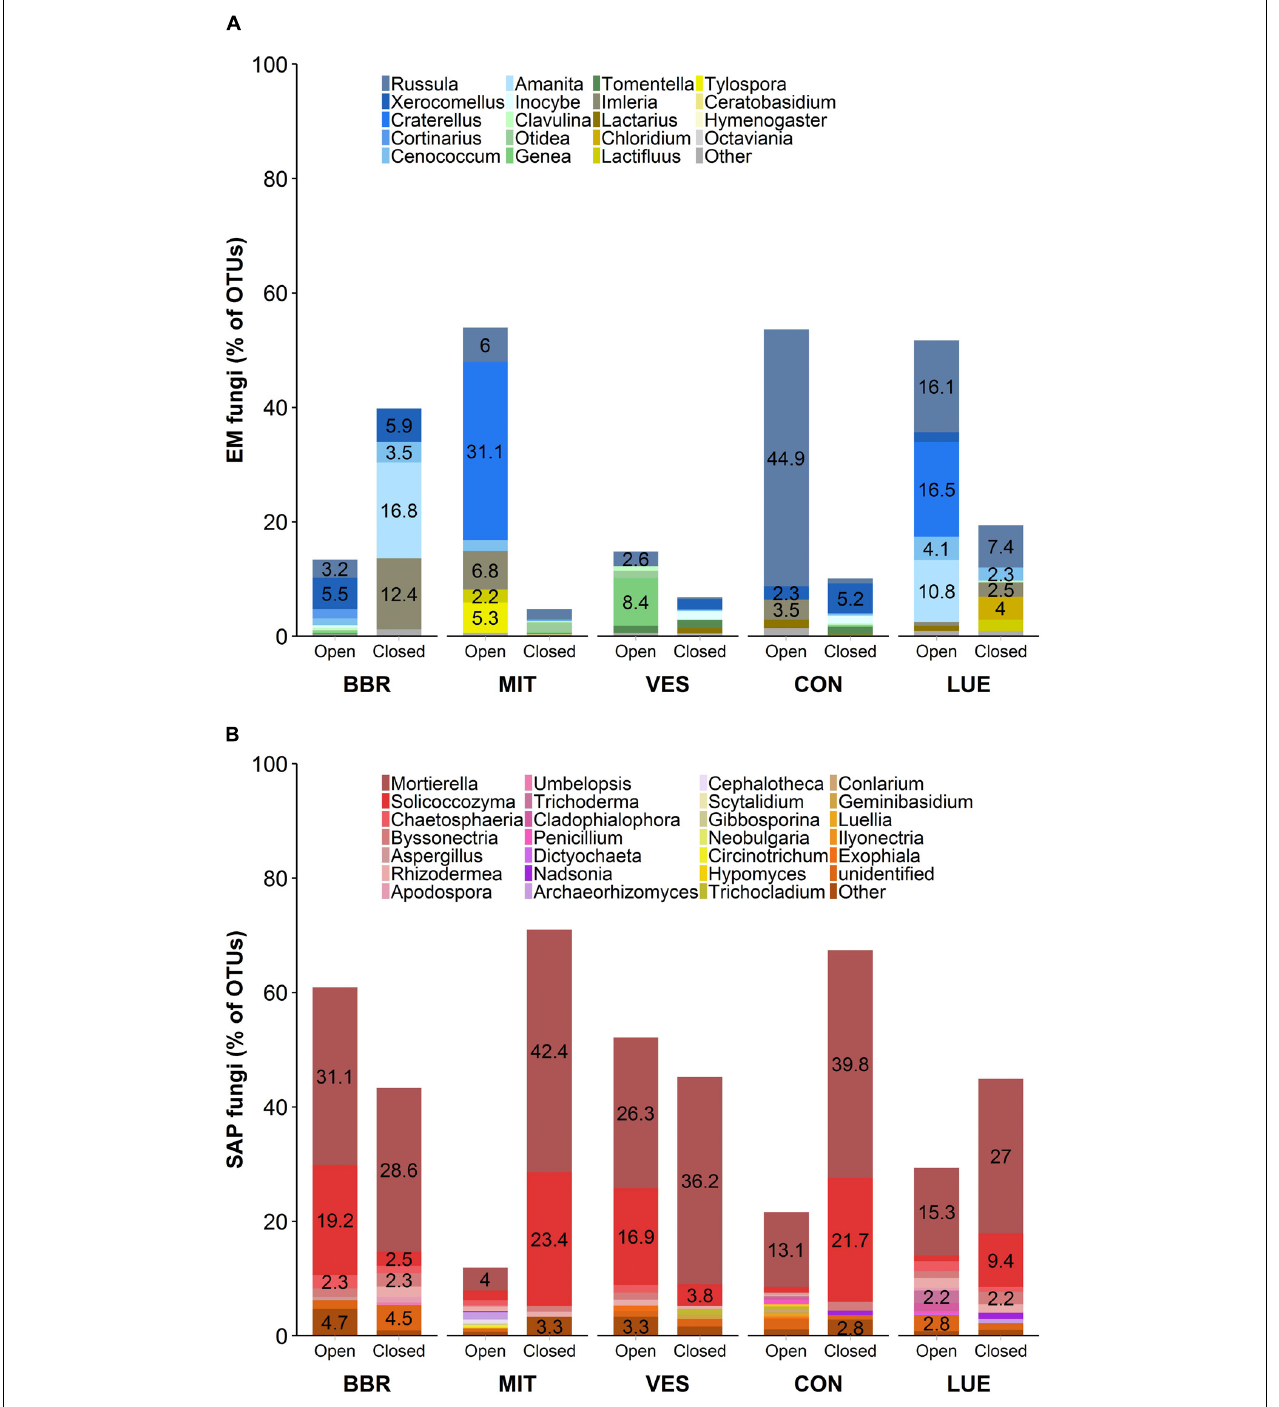
FIGURE 2 | Fungal community composition of (A) ectomycorrhizal (EM) fungi and (B) saprotrophic (SAP) fungi in open and closed IGTs based on Illumina Sequencing data in Bad Brückenau (BBR), Mitterfels (MIT), Vessertal (VES), Conventwald (CON), and Lüss (LUE) after 18 months of exposure ( n = 5).